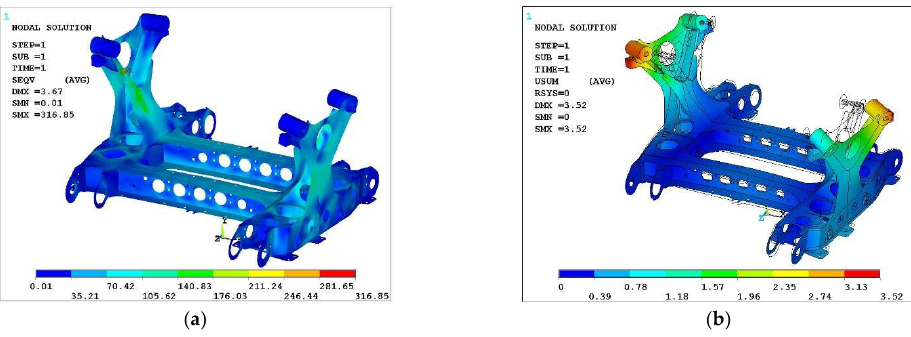
Figure 7. Static strength analysis of motor hanger. ( a ) Stress nephogram; ( b ) Displacement nepho- gram.